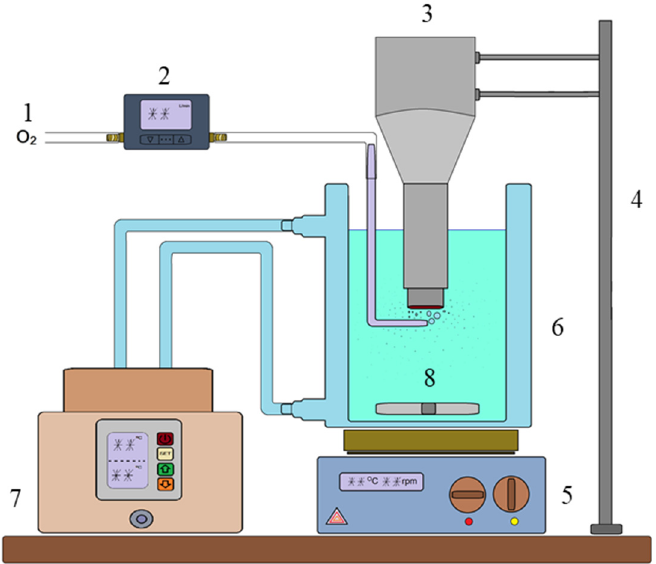
Figure 4. Schematic diagram of experimental leaching system: 1—oxygen cylinder; 2—gas flow meter; 3—ultrasonic processor; 4—test bench; 5—hot plate; 6—jacketed reactor; 7—thermostatic bath; 8—magnetic stirrer.